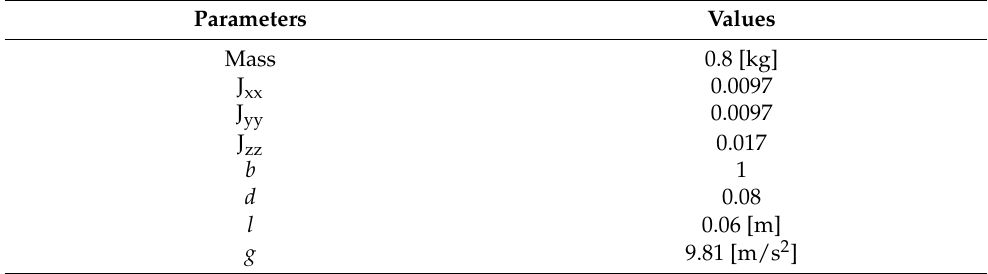
Table 1. Parameters of Tello quad-rotor.